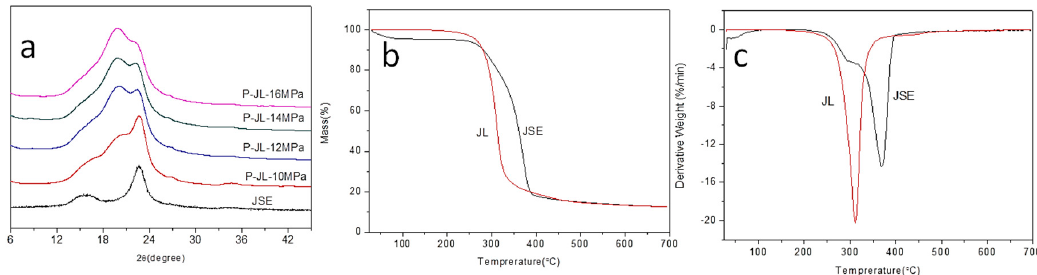
Figure 6. X-ray di ff raction (XRD) patterns ( a ), thermogravimetric (TG) curves ( b ), and di ff erential thermogravimetric (DTG) curves ( c ) of pretreated jute (JSE) and JSE laurate